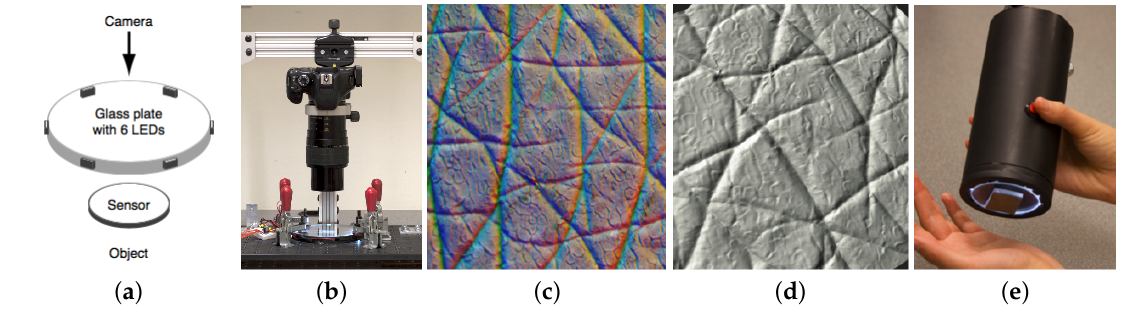
Figure 10. The GelSight device with matte lcoating and side illumination [8] (Got copyright permission from Association for Computing Machinery). ( a ) the schematic of the optical system: six LEDs with a single color (white) is evenly distributed on the side of the supporting glass, and the sensor elastomer is in the central area of the supporting plate; ( b ) the bench setting of the design: a digital single-lens reflex (SLR) camera and macro lens is used to capture the high-resolution images on the sensor surface; ( c ) the captured image of human skin. ( d ) the reconstructed geometry of the skin from ( c ); ( e ) the portable design of the